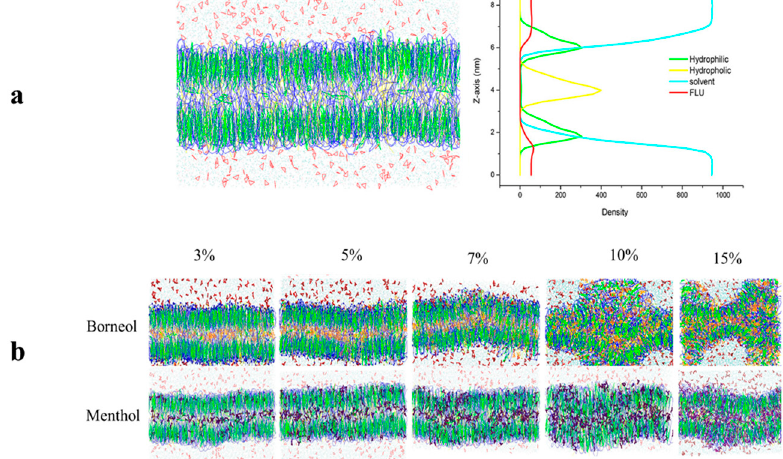
Figure 2. ( a ). The morphology of the initial bilayer together with its density distribution profile along the z -axis; ( b ). Stratum corneum (SC) bilayer morphology after exposure to different concentrations of borneol ( top ) and menthol ( below ).